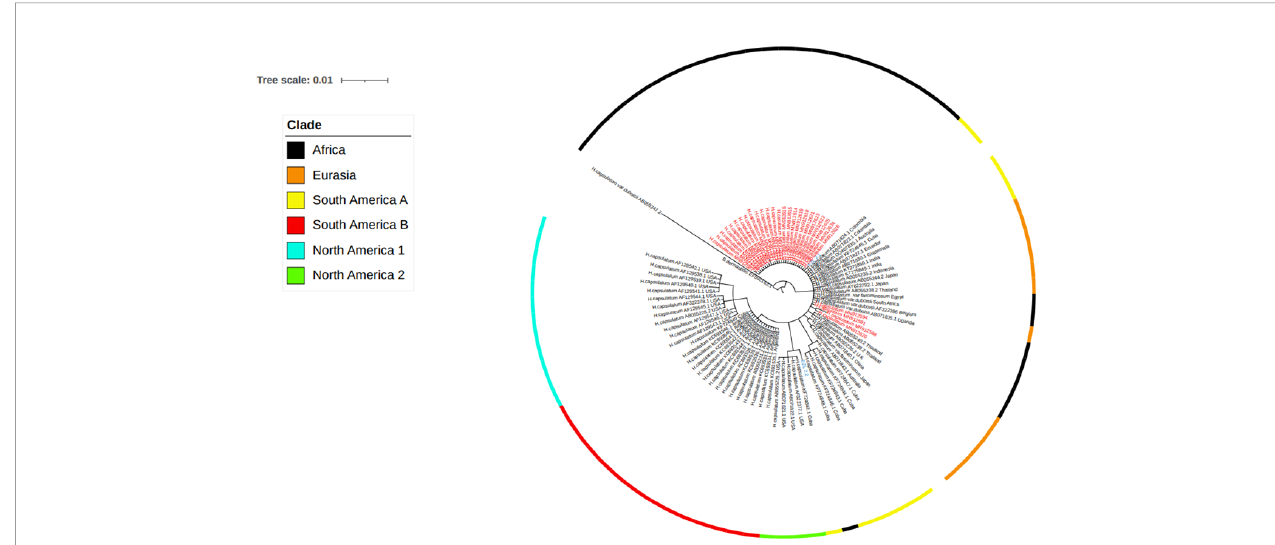
FIGURE 5 | Evolutionary analysis of Histoplasma capsulatum isolated from Ethiopia and other countries by maximum likelihood method. The evolutionary history was inferred by using Bayesian inference with the Tamura-Nei model +gammamodel. Clades are presented as color tips parallel to sample names which also indicate their countries of origin and NCBI accession number. Sample names written in red color font (Ethiopian) are those generated by the present study, while two Ethiopian isolates that are written in blue font color were generated by previous study in